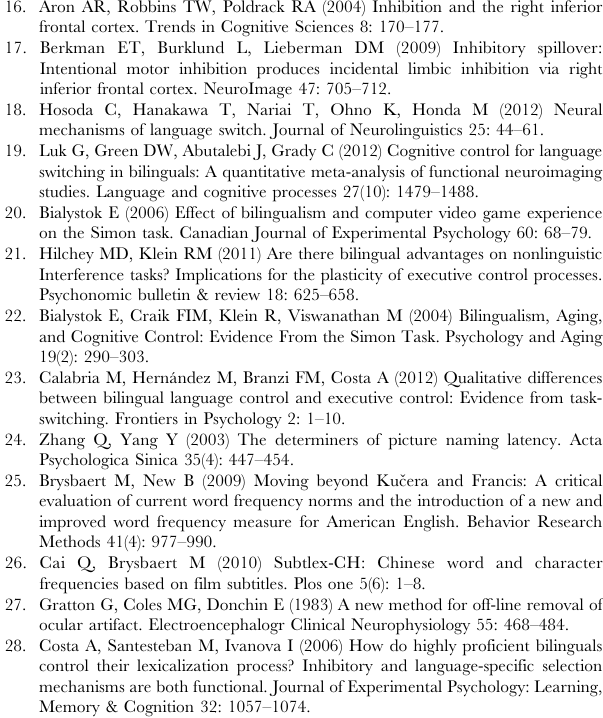
Table S1 Demographic and language proficiency data. Table S2 Language switching materials. Table S3 Simon task latency data. Table S4 Language switching latency data. Table S5 N2 amplitude data. Table S6 LPC amplitude